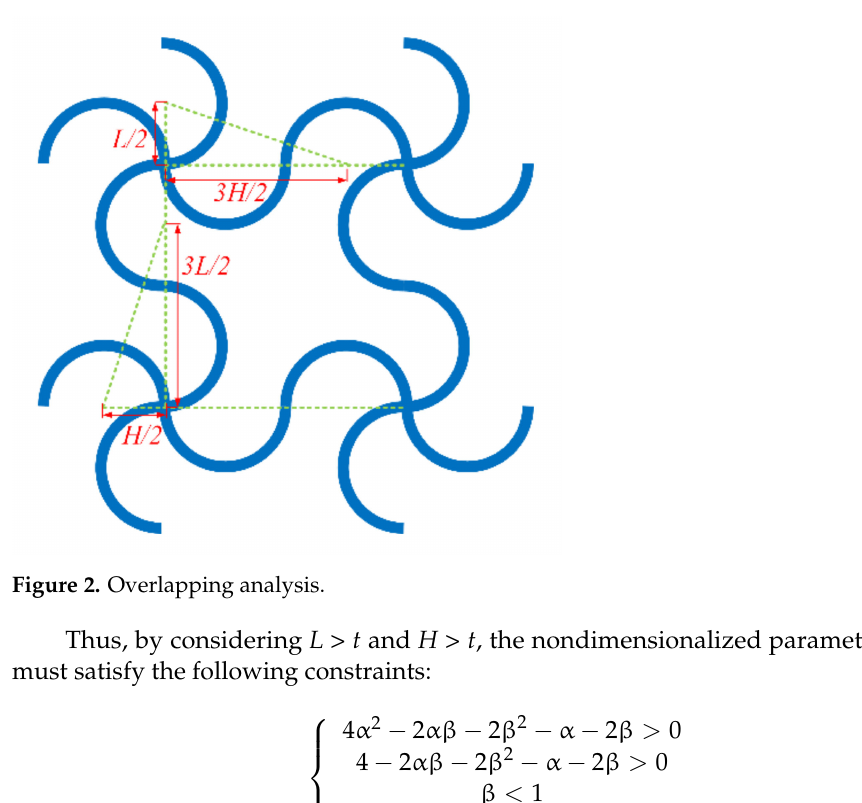
Figure 1. Geometry of the structure: ( a ) 3D structure and ( b ) 2D unit cell.